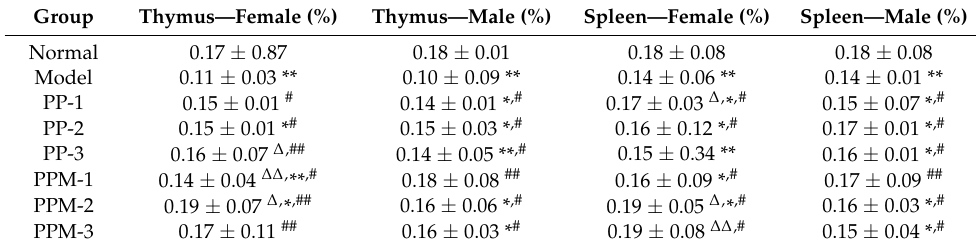
Table 2. Thymus and spleen